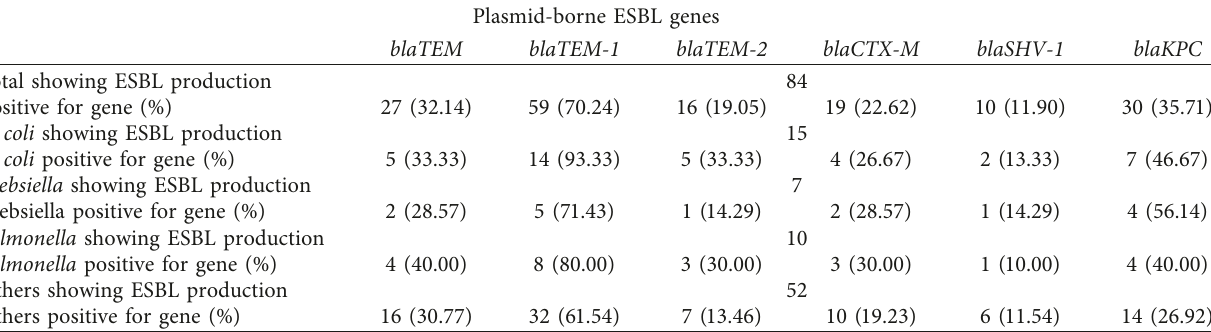
Table 9: Prevalence of plasmid-borne beta lactamase genes detected by PCR. Plasmid-borne ESBL